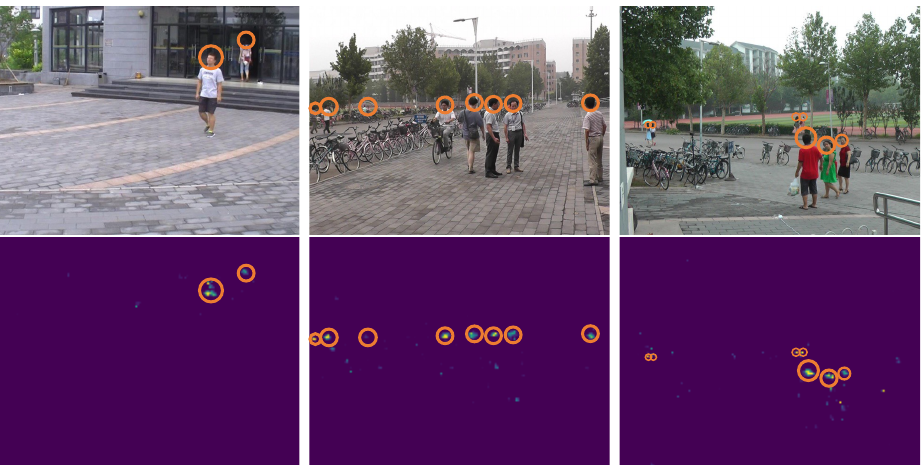
Figure 9. Qualitative analysis of MiCrowdNet. MiCrowdNet accurately creates density maps (second row) from the images (first row).